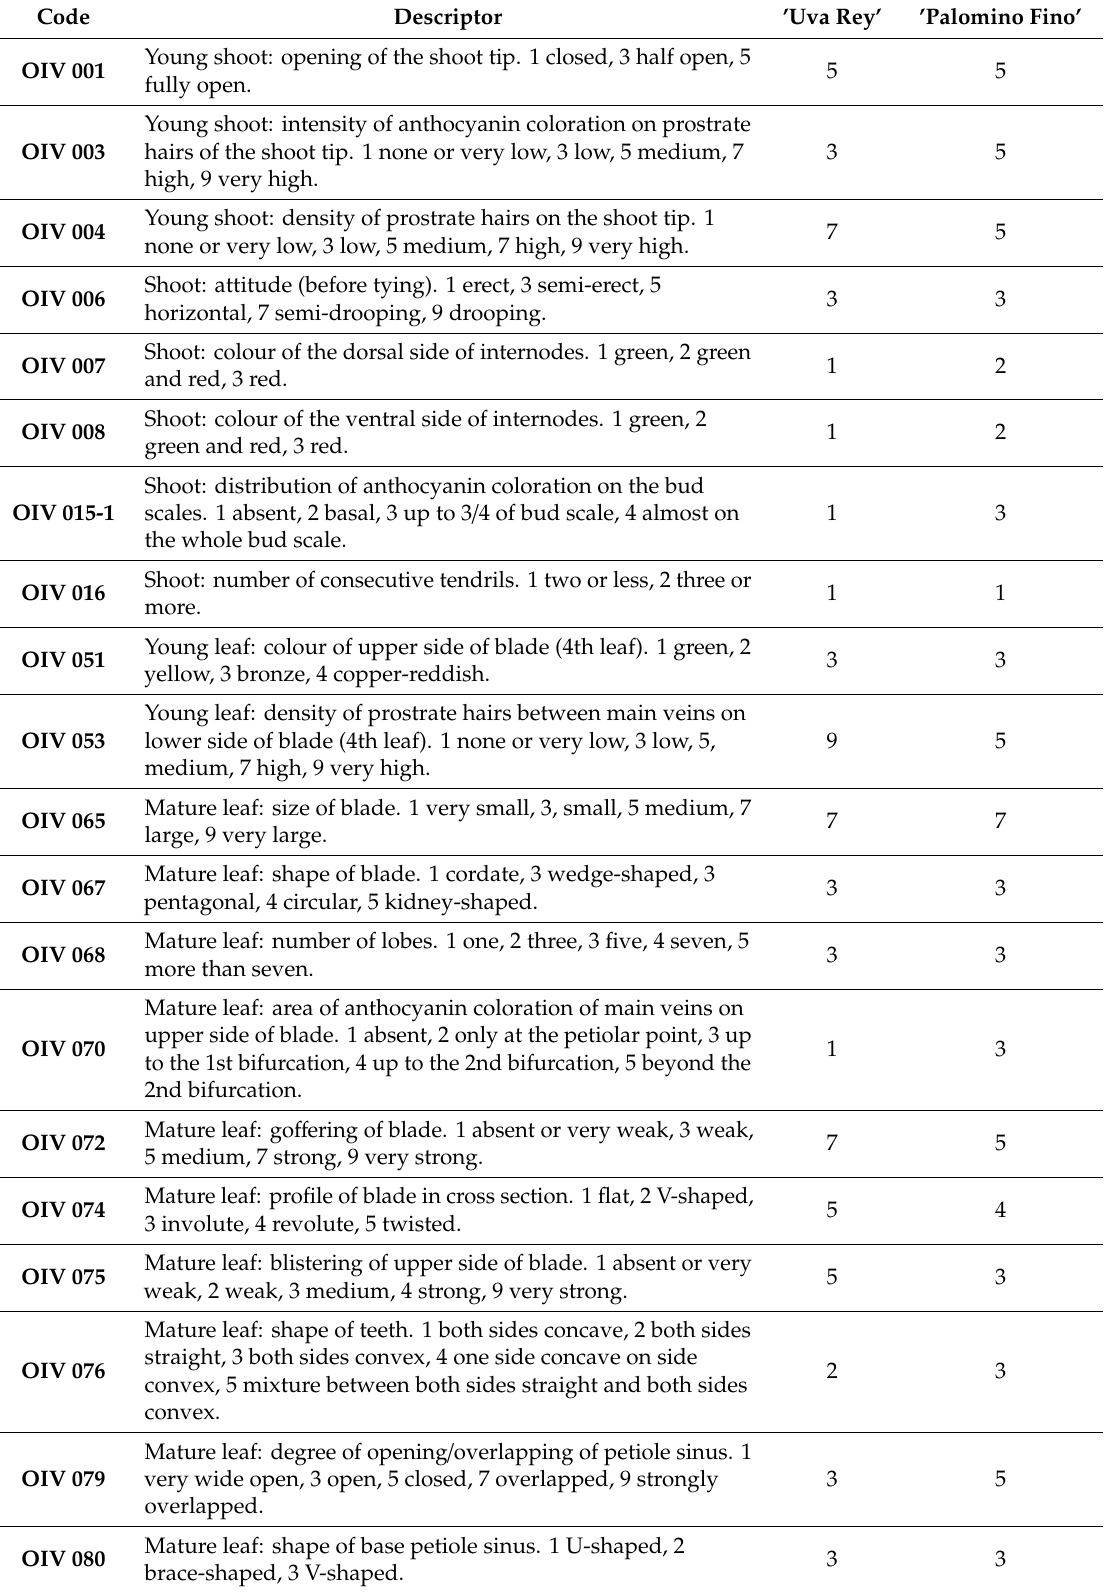
Table 2. Ampelographic description of ’Uva Rey’ and ’Palomino Fino’ cultivars using the International Organisation of Vine and Wine (OIV)